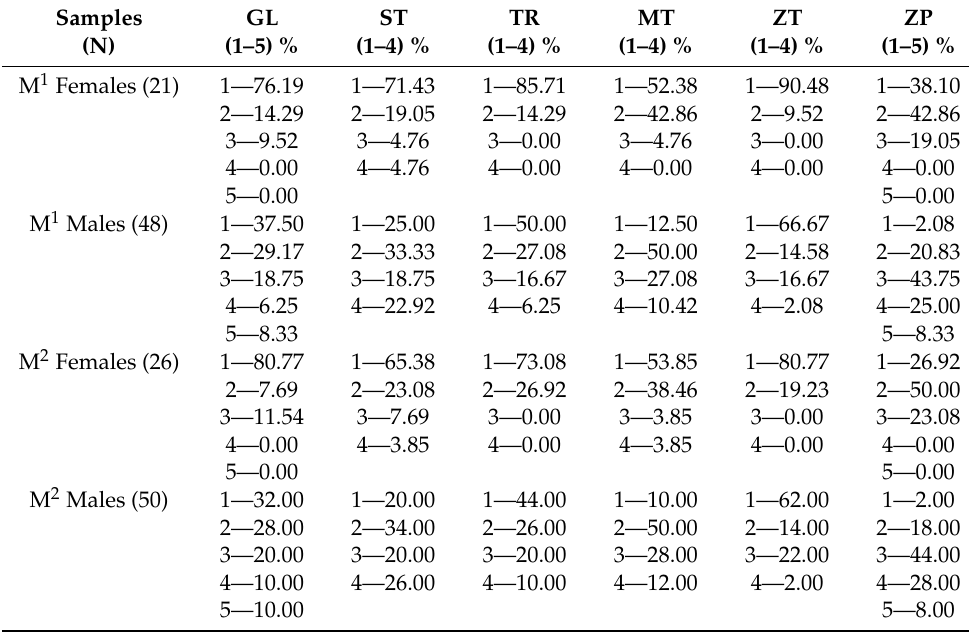
Table 4. The proportion (%) of the presence of the grades (from 1 to 4 or 5) of the massiveness of the examined regions of the facial skeleton (GL, glabella; ST, superciliary ridge; TR, trigone; MT, malar tubercle; ZT, zygomaxillary tuberosity; ZP, zygomatic process of temporal bone) in the analyzed cranial samples; N—maximal number (100%) of the specimens in the sample for which the data about the grade of massiveness for the examined facial regions were